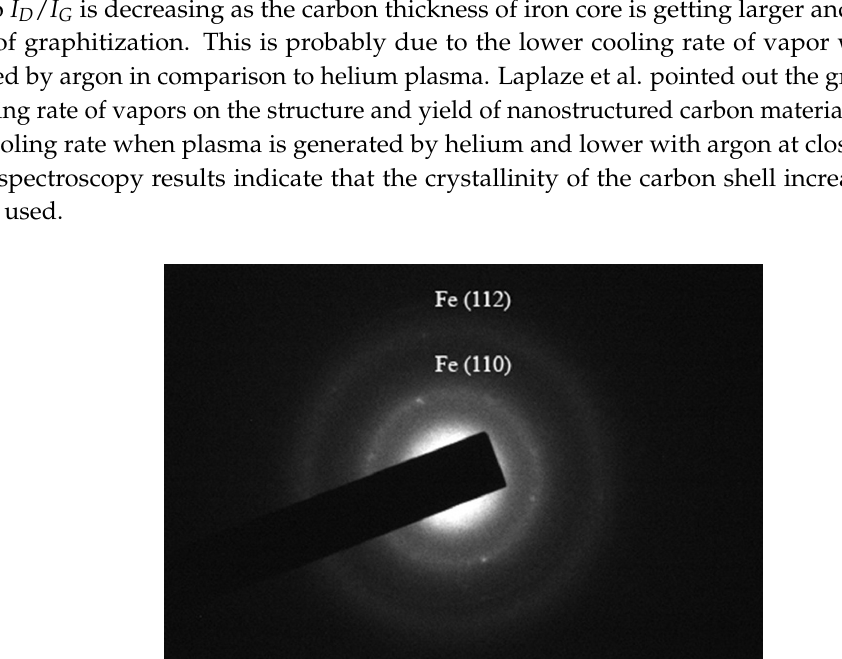
Figure 10. ( a ) TEM image at micro scale; ( b ) chemical mapping in conjunction with TEM image ( a ), red points accumulation represent appearance of iron in particles; ( c ) EDX (energy dispersive X ‐ ray) spectrum, red peak corresponds to Fe and blue peak is Cu from grid of the sample.